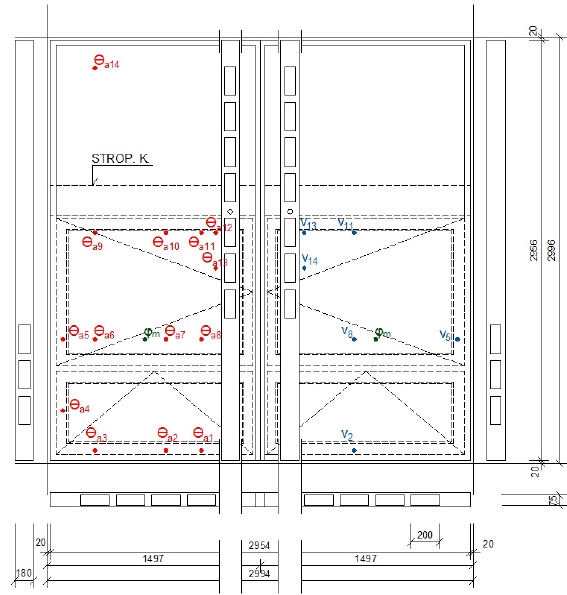
Figure 16: Scheme of distribution of measuring points for measured parameters of the cavity in the completed part of double skin facade Θ a , x - measuring points for temperature measurement ( ∘ C), v x - measuring points for measuring air velocity (m/s), ϕ points for measuring relative humidity